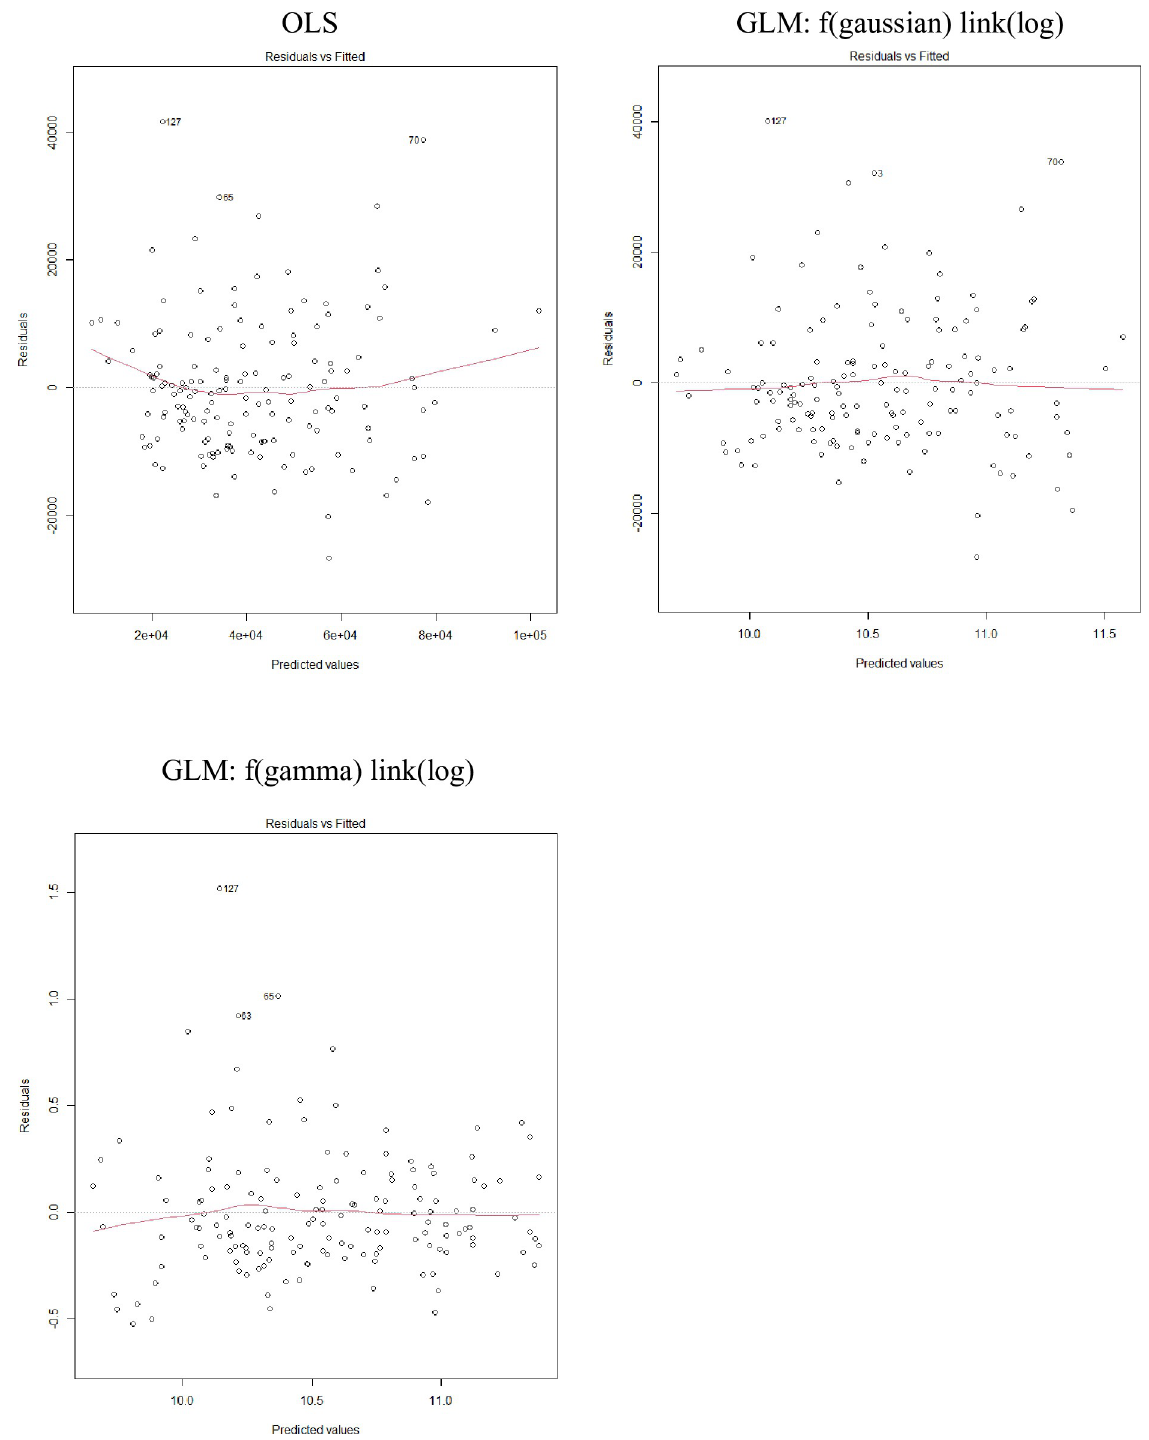
Fig 6. Residuals vs. fitted values plots for various American Samoa longline fishery trip cost models � . � Residuals represent deviance residuals for GLM. The red line represents the average value of the residuals at each value of fitted value.